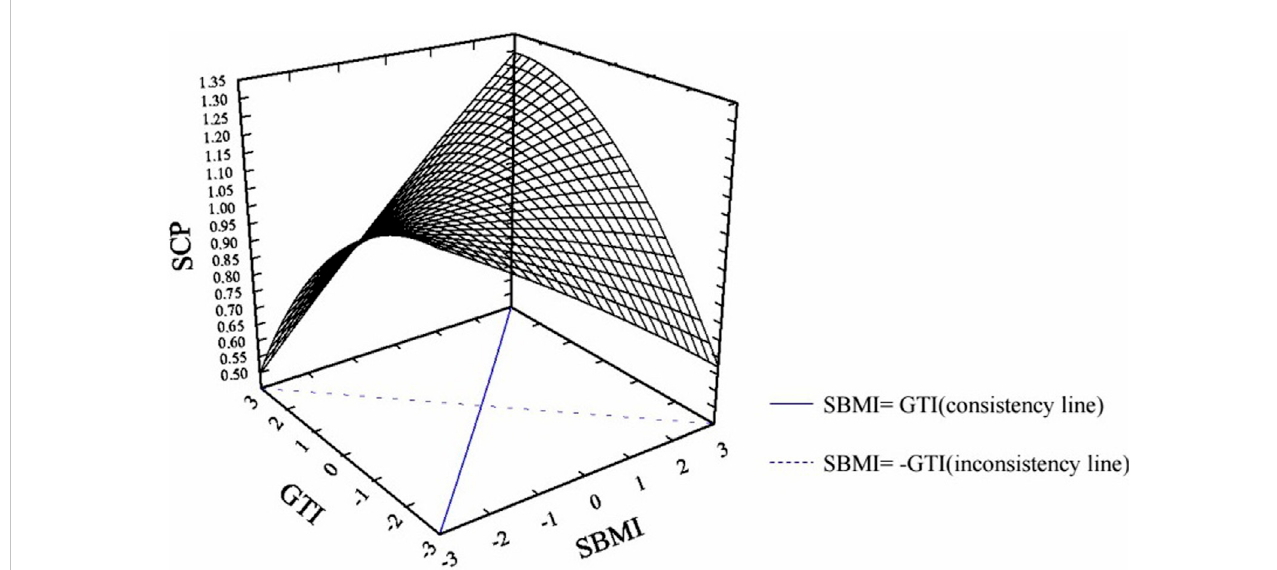
FIGURE 7 Surface graph of SBMI-GTI consistency/inconsistency on SCP, when the degree of corporate strategic aggressive is high.